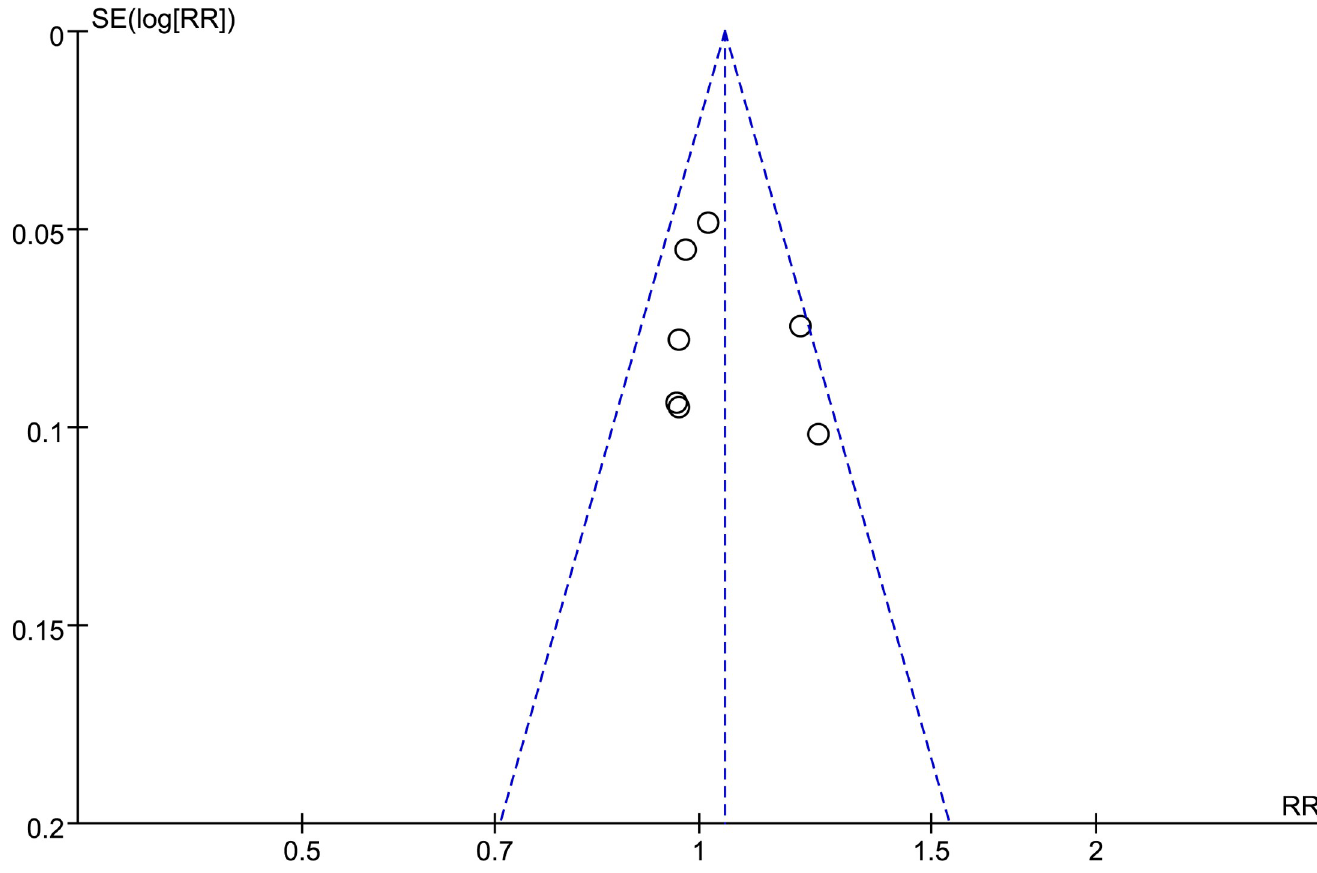
Fig 4. Funnel plots to test for publication bias.